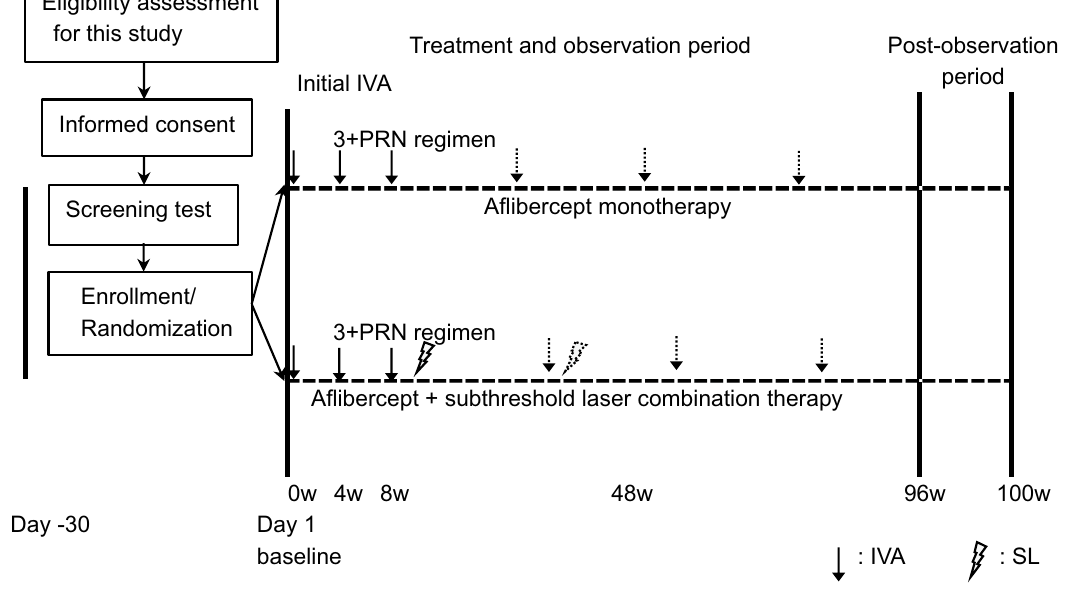
Figure 5. Flow diagram of study recruitment, randomization, study treatment and observations. IVA intravitreal aflibercept; 3 + PRN , initial 3 monthly injections and pro re nata; SL, subthreshold